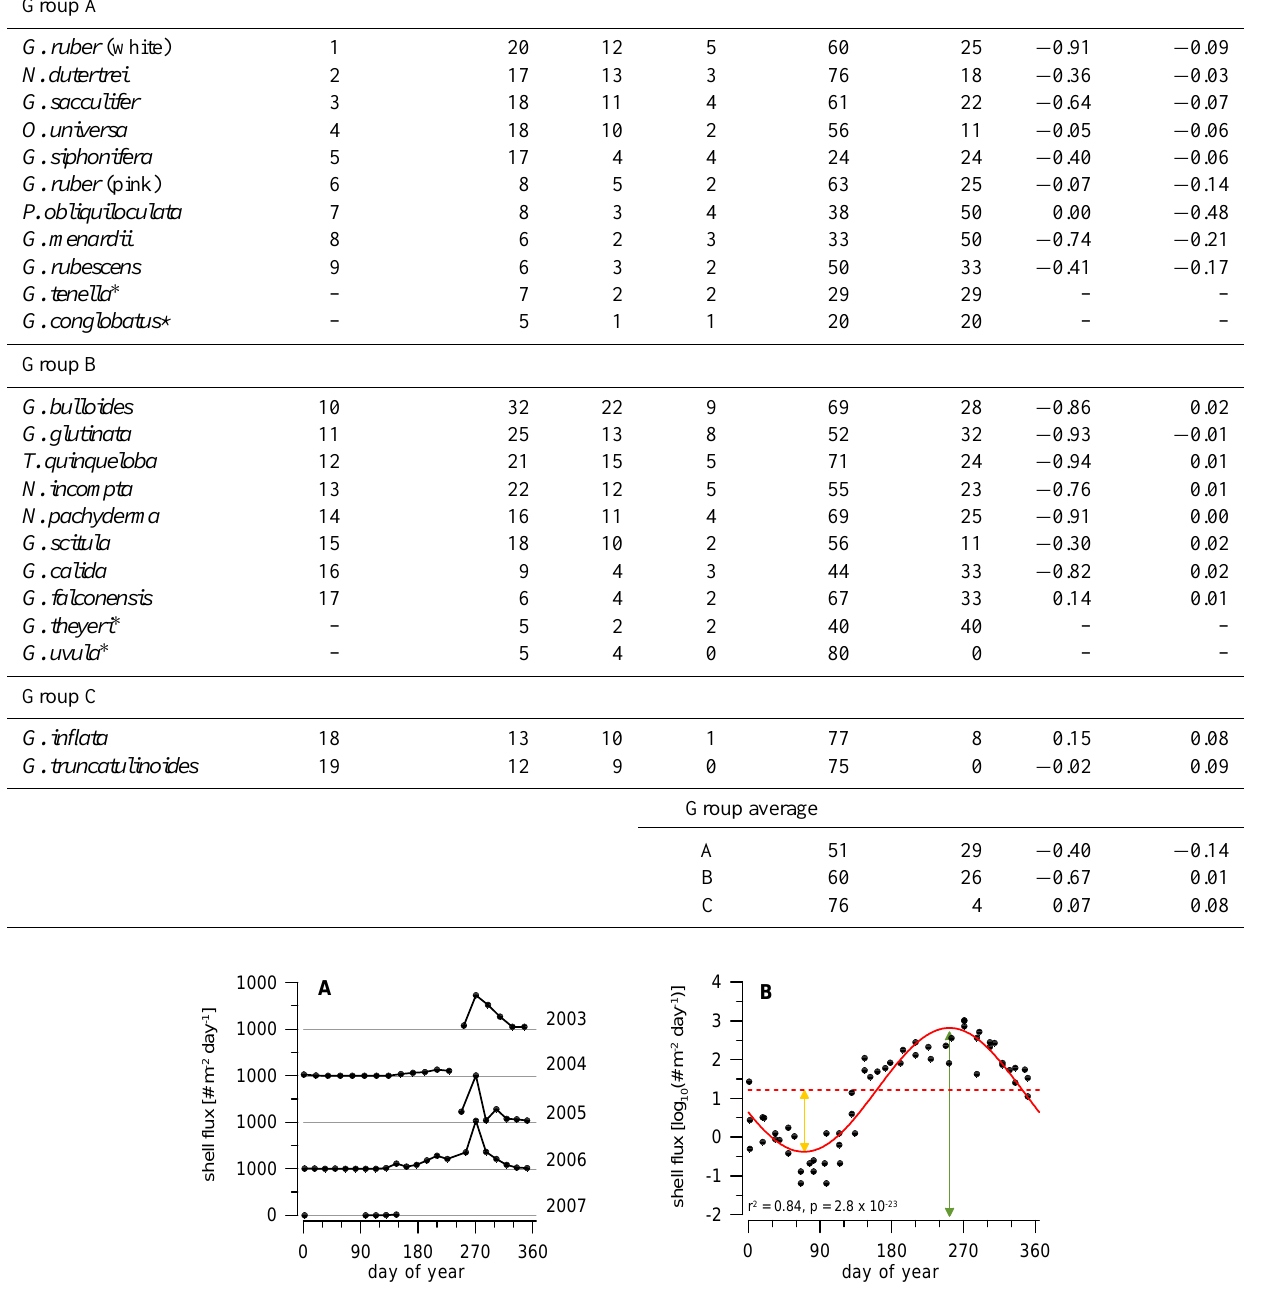
Figure 3. Example of the periodic regression approach. (a) Raw data plotted vs. year day and at middates of collection intervals. (b) Log- transformed data and fitting approach; the thick red line represents the best fit for the two models tested. The dashed horizontal red line is the periodic mean, the yellow arrow indicates the amplitude of the cycle and the green arrow indicates the modelled peak time. Data are from T. quinqueloba from site